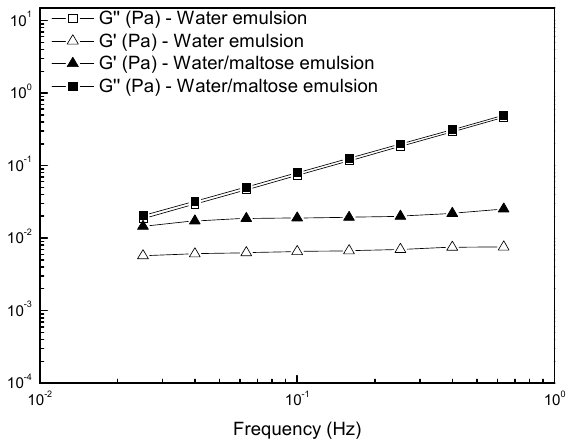
Figure 4. Frequency dependence of the storage modulus G’ and loss modulus G” for the studied emulsions.